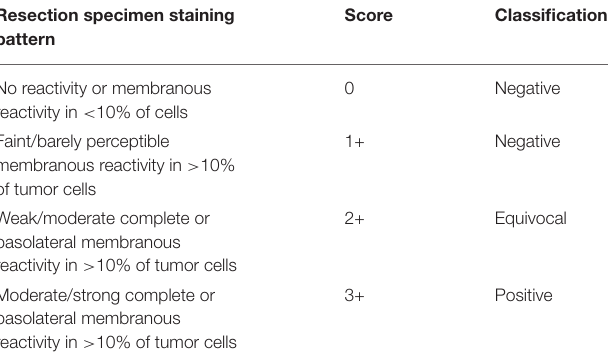
gastroesophageal junction